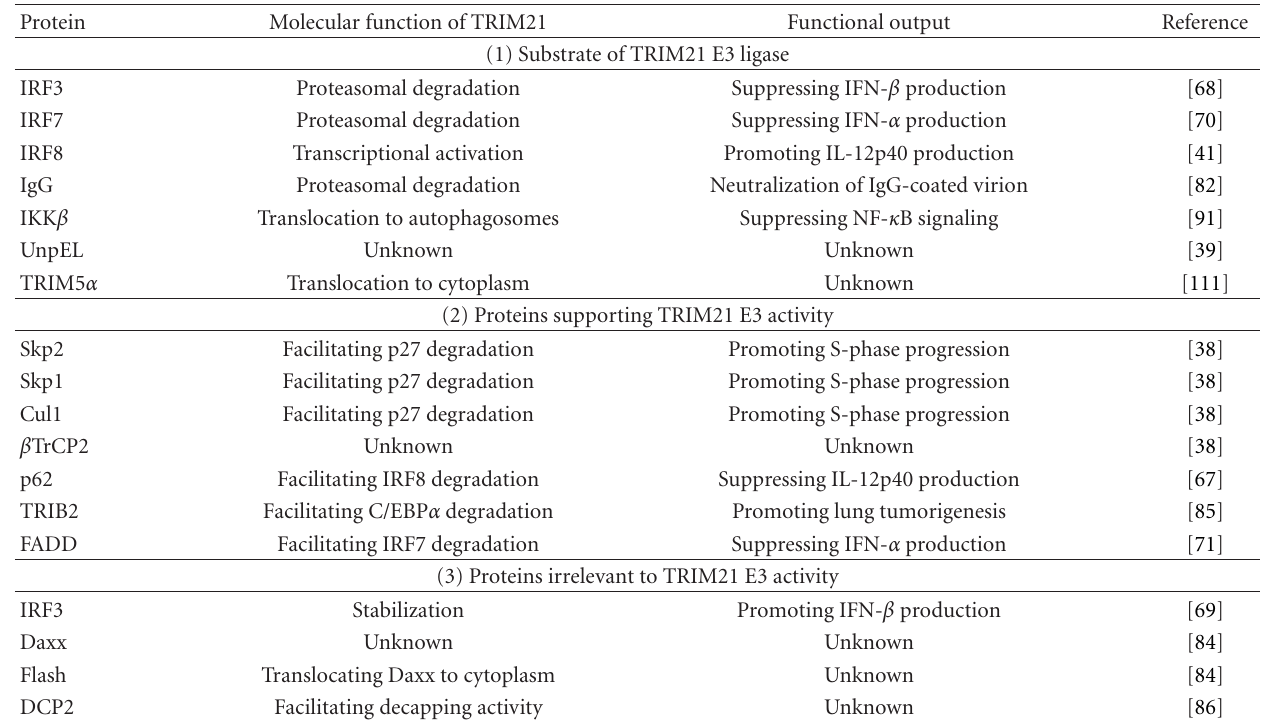
Table 2: TRIM21-binding